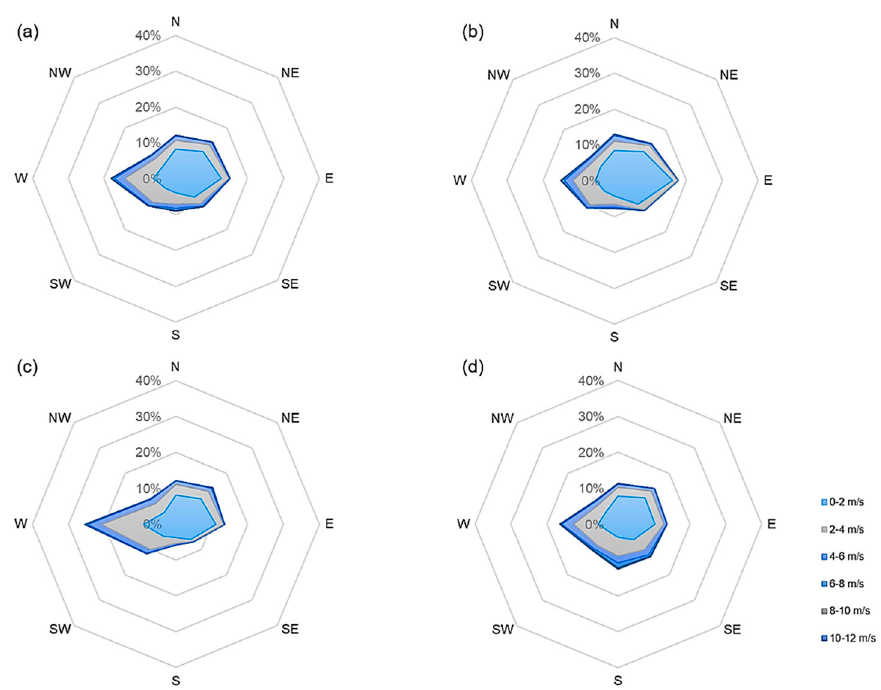
Figure A4. Pollen impaction (pollen grains/cm 2 ) on the vertical slides in 2020 for the pollen seasons: pre-pollen season: 18.03–02.04 (green), main pollen season: 02.04–23.04 (pink), post-pollen season: 23.04–14.05 (brown) and total (blue). For pollen traps 1 ( a ), 2 ( b ), 3 ( c ) and 4 ( d ) at the location Schorndorf.